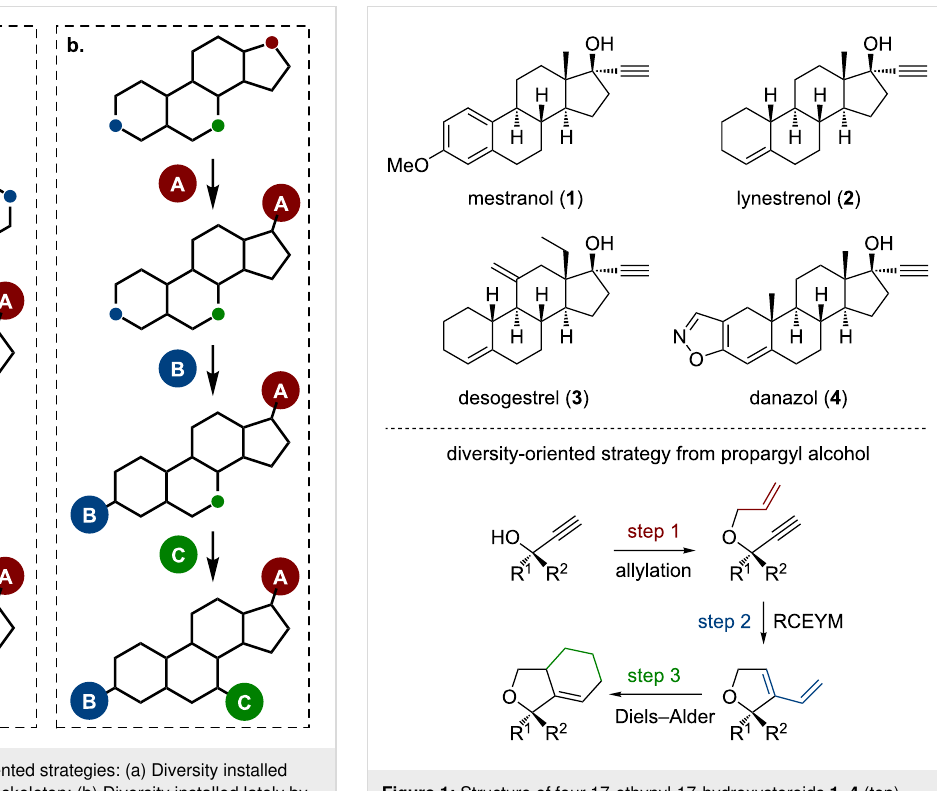
Figure 1: Structure of four 17-ethynyl-17-hydroxysteroids 1 – 4 (top) and how they could be used to generate diversity